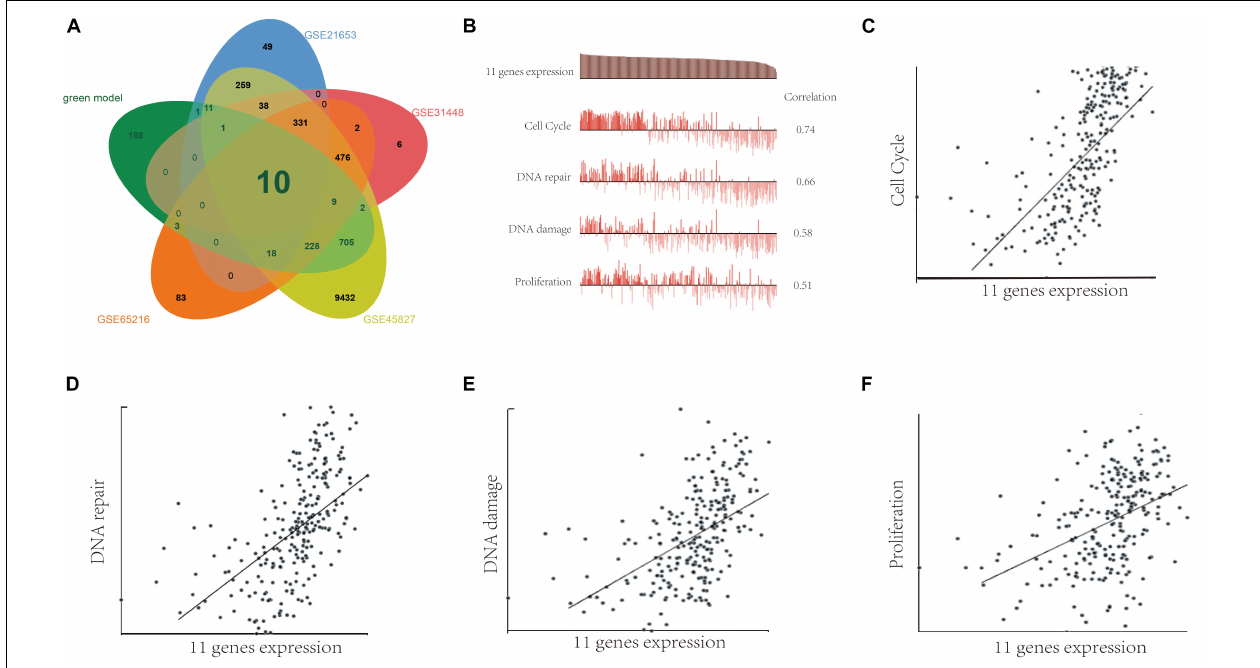
FIGURE 7 | The function of SAE1 coexpression genes in breast cancer cells. (A) Venn diagrams showing relationships between DEGs and green model genes. (B) Single-cell analysis indicated that those 11 genes are primarily involved in regulation of the cell cycle, DNA damage and repair, and proliferation in breast cancer. (C) Correlation between 11 gene expression and cell cycle. (D) Correlation between 11 gene expression and DNA repair. (E) Correlation between SAE1 expression and DNA damage. (F) Correlation between 11 gene expression and cell